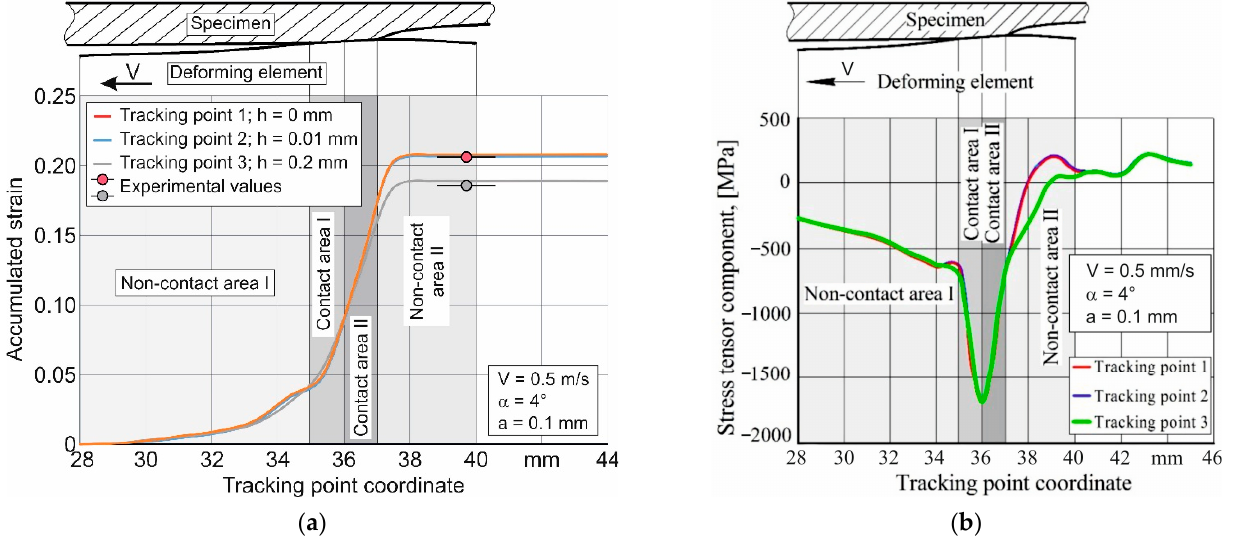
Figure 10. Dependence of the accumulated strain ε 0 and the axial component of the stress tensor σ z on the tracking point coordinate: ( a ) accumulated strain, ( b ) axial component of the stress tensor. The accumulated strain increases insignificantly within the non-contact zone I to a value of about 0.04, as shown in Figure 10a. In contact zones I and II, there is a significant increase in the accumulated strain to a value of about 0.16–0.17. After the machining cycle